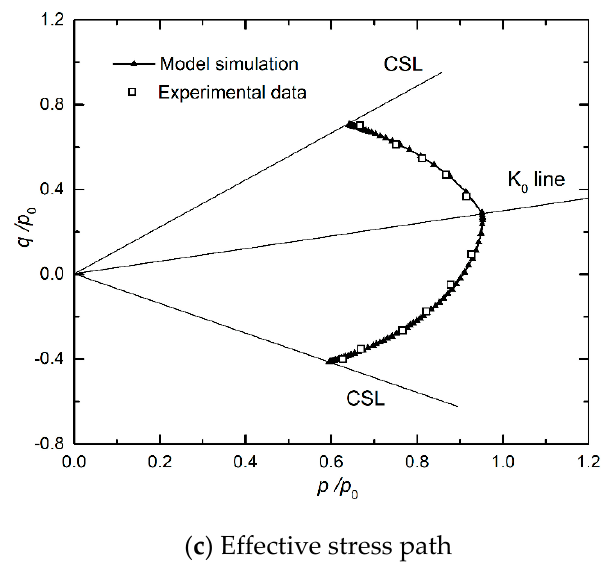
Figure 5. A comparison between the model simulation and experimental data with